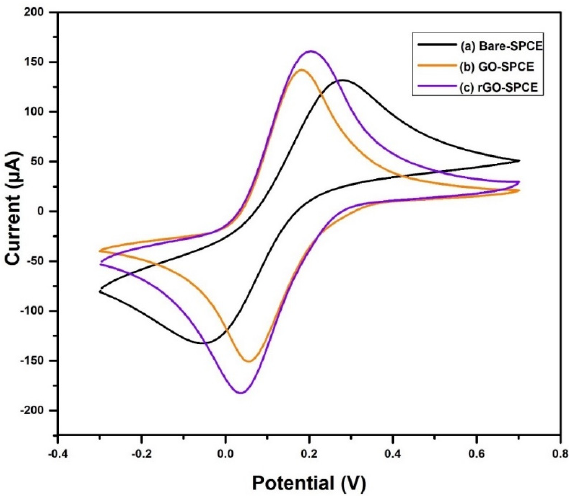
Figure 9. Cyclic voltammograms (CV) of ( a ) bare—SPCE, ( b ) GO—SPCE, and ( c ) rGO—SPCE in 0.1 M of KCl solution with 5 mM K 3 Fe(CN) 6 at a scan rate of 100 mVs − 1